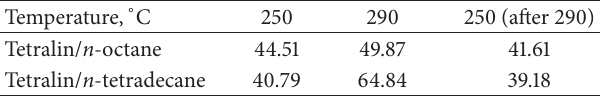
Figure 6: The 𝜐 𝐿 + (𝐶 0 calculated by SRK equation of state.